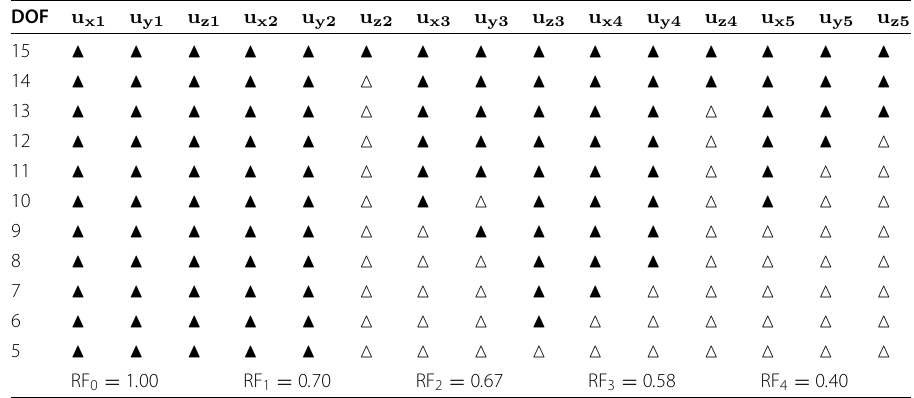
Fig. 17 FE and NN results for 0/90/0, a/h = 25 and 75, three layers with ten neurons Table 19 BTD models, 0/90/0/90, a/h =